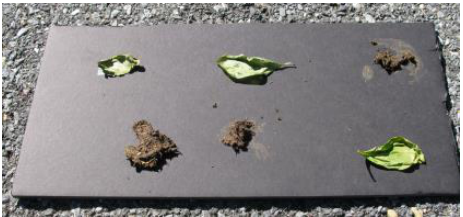
Figure 10. Photograph of the target with three spinach leaves and three dollops of dairy manure.